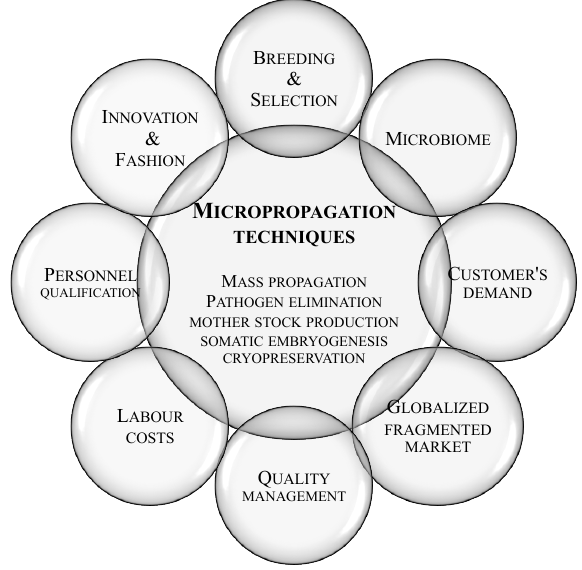
Fig. 6: Micropropagation of plants: intersections in research and commer- cial